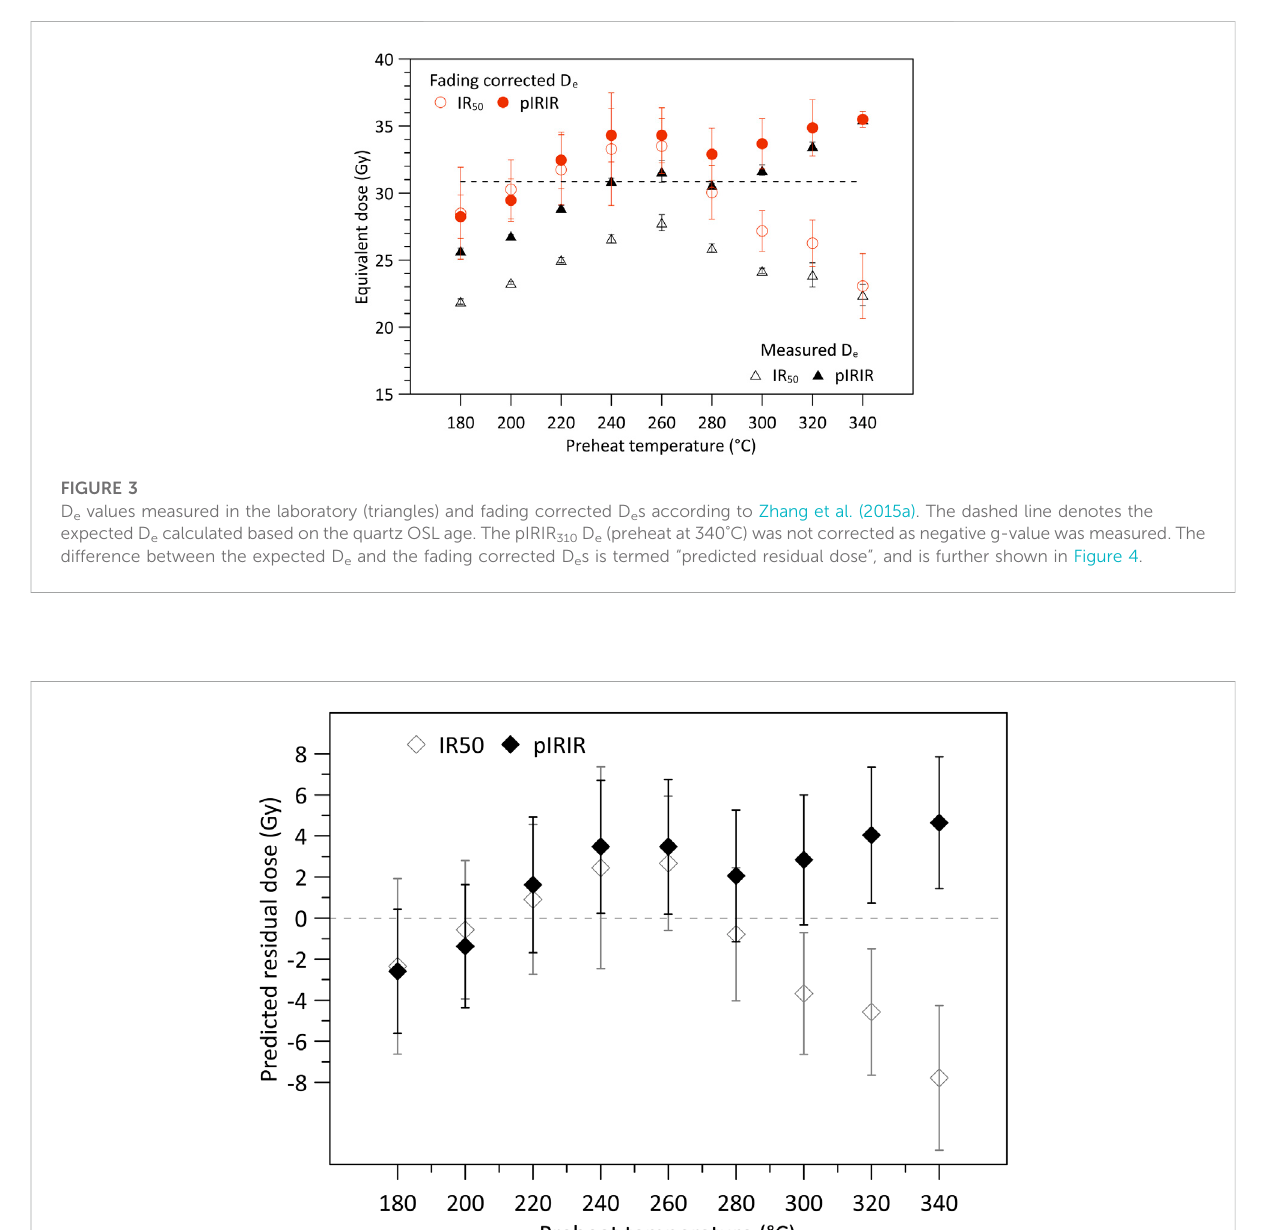
Frontiers in Earth